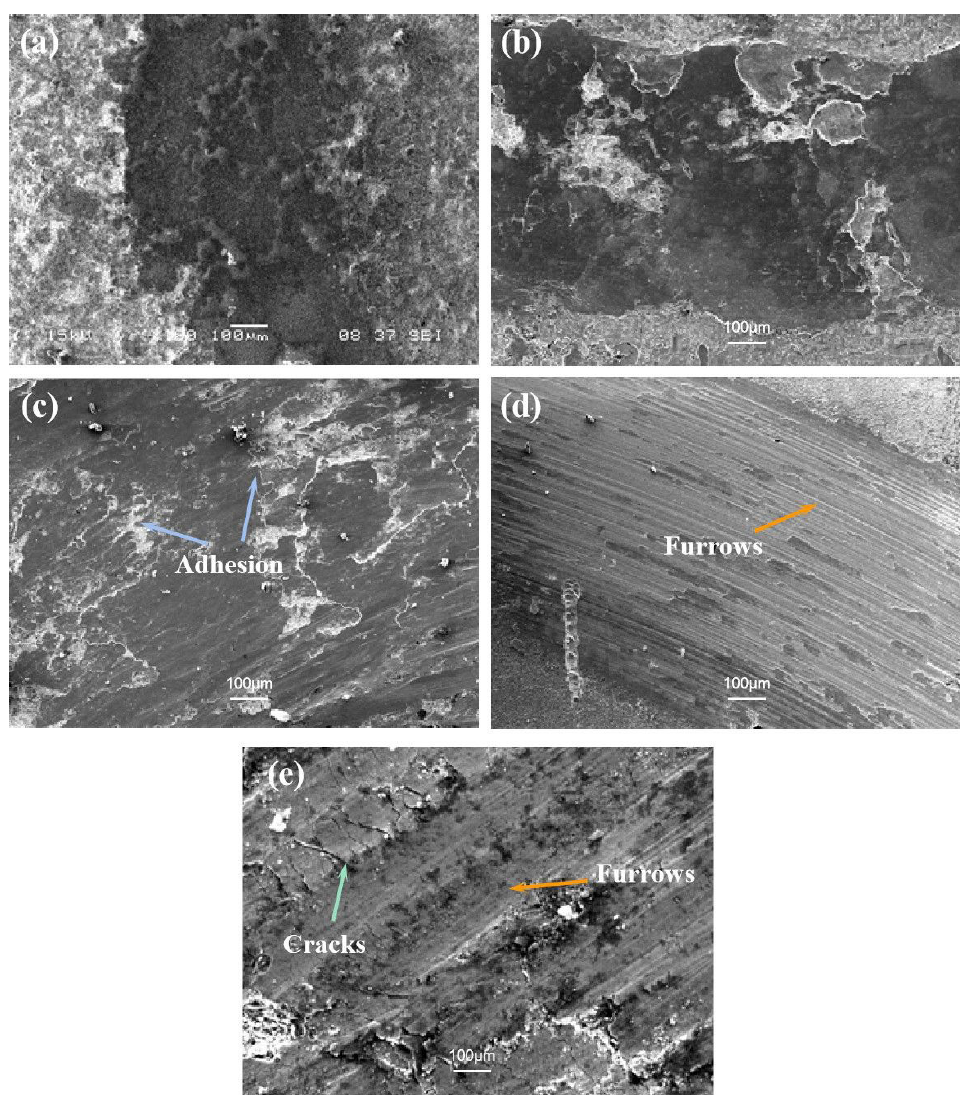
Figure 11. SEM images of worn morphology of as-fabricated composites: (a) without adding MoS of the coatings with MoS concentration of 0.5 g·L -1 and 1.0 g·L -1 , respectively; (d) and (e) abrasive wear of the coatings with MoS 2 concentration of 1.5 g·L -1 and 2.0 g·L -1 ,